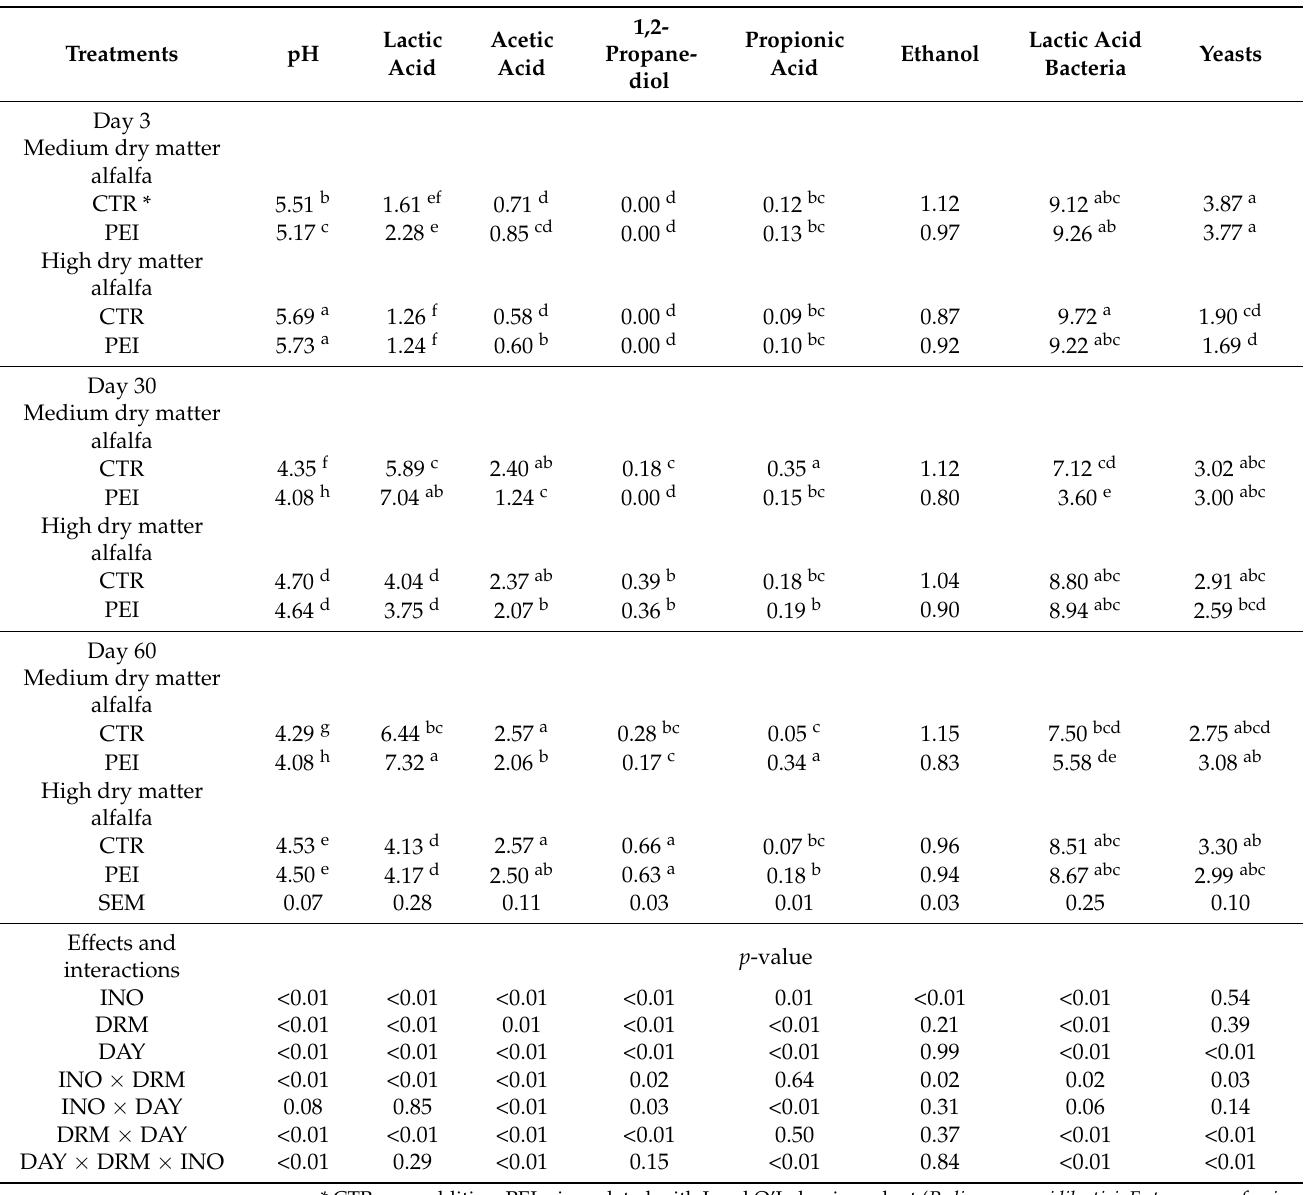
Table 5. The pH, fermentation end products (% of DM) and microbial populations (log cfu/g wet weight basis) of alfalfa silage ensiled for 3, 30 and 60